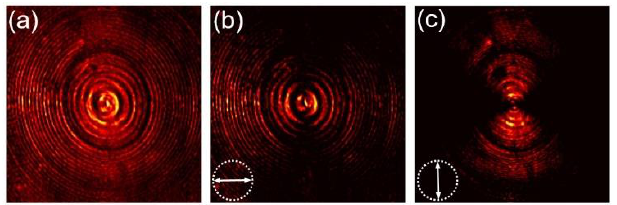
Figure 4. Intensity distribution of light field transmitted from the metalens in the case of horizontally polarized beam incidence. ( a ) Total intensity; ( b ) Horizontal component; ( c ) Vertical component. The arrows depict the orientation of polarization analyzer.